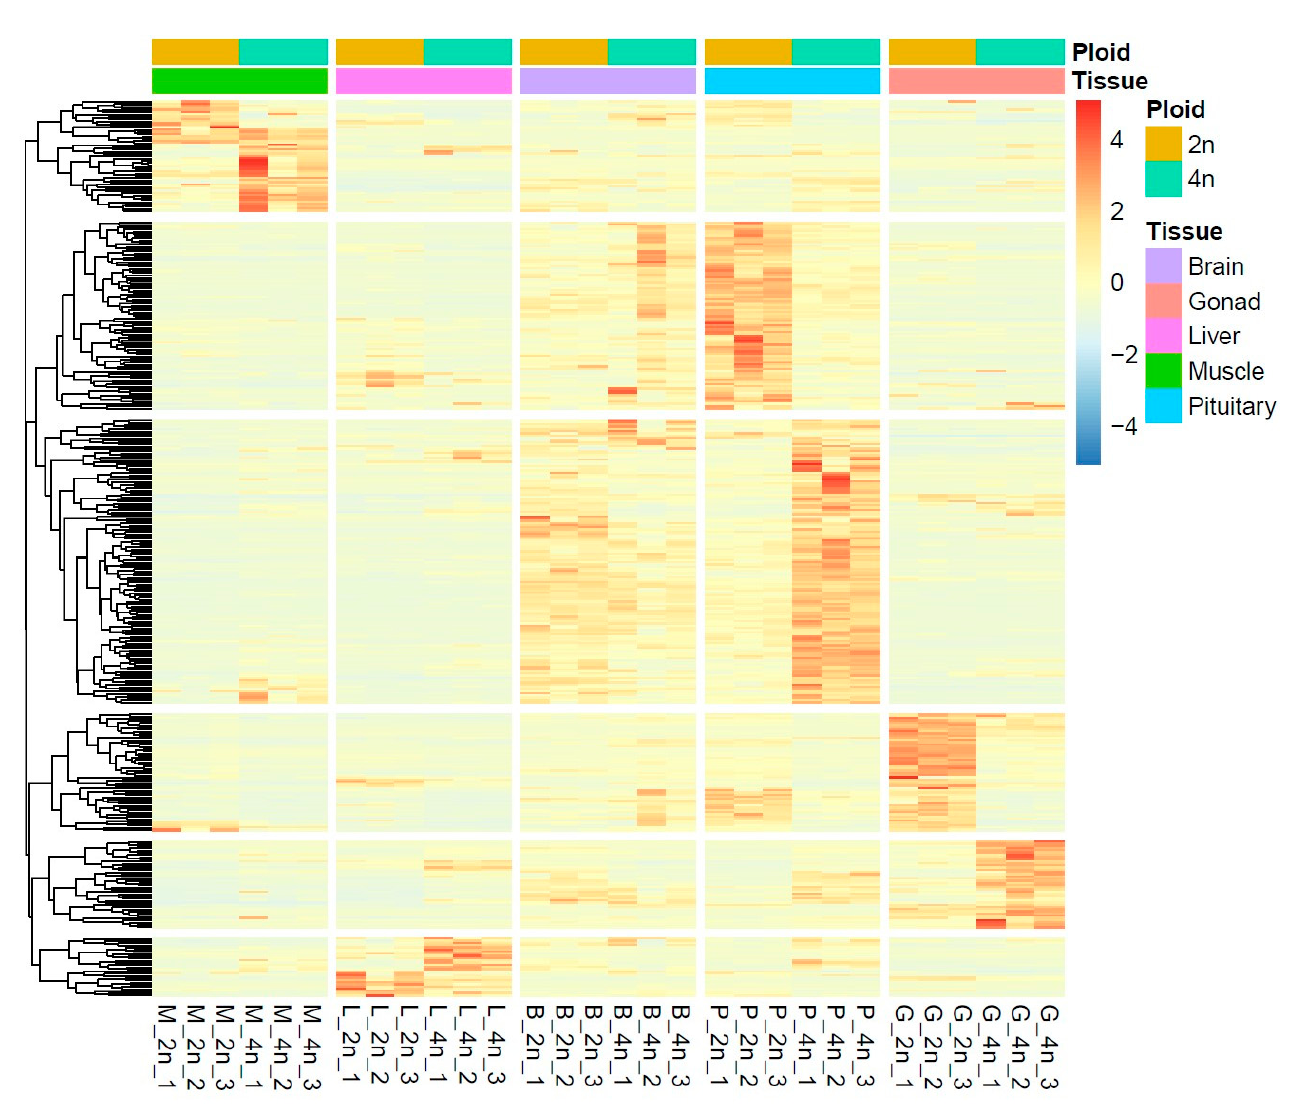
Figure 4. The heatmap of the key genes related to growth and gonadal development. The 2n and 4n indicate diploid and tetraploid individuals.